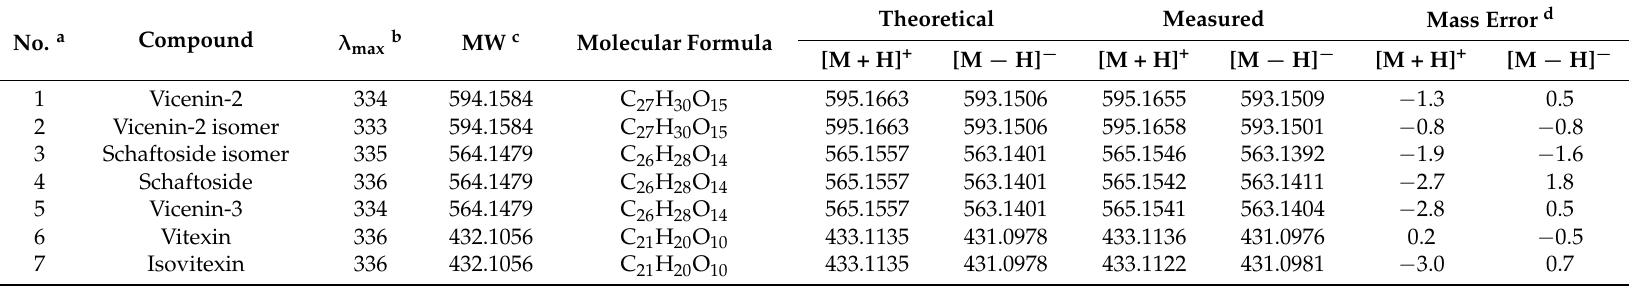
Table 1. Identification of the major flavone C -glycosides in C.